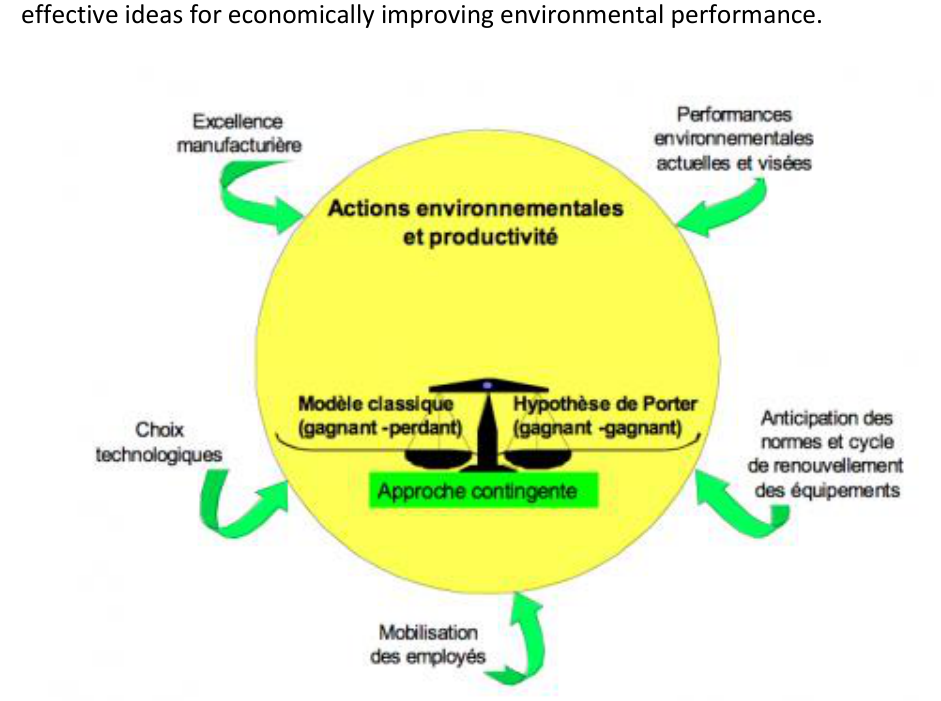
Figure 1: Contingency of the relationships between environment and